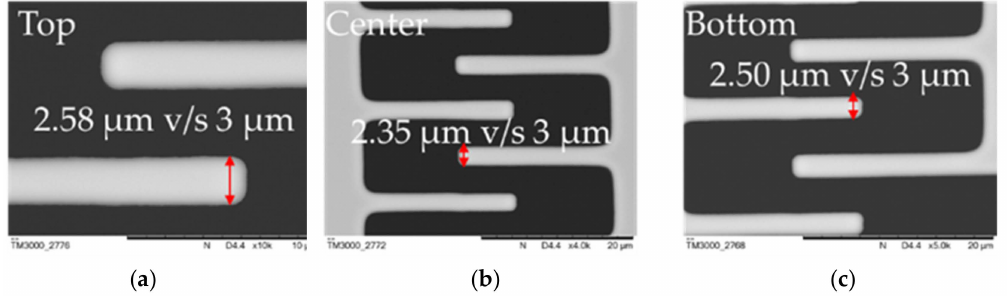
Figure 5. Fabricated v / s design dimensions through SEM micrograph analysis of the drive fingers for comb drive-based translational MEMS platform in various parts of the actuator: ( a ) top; ( b ) center; ( c )